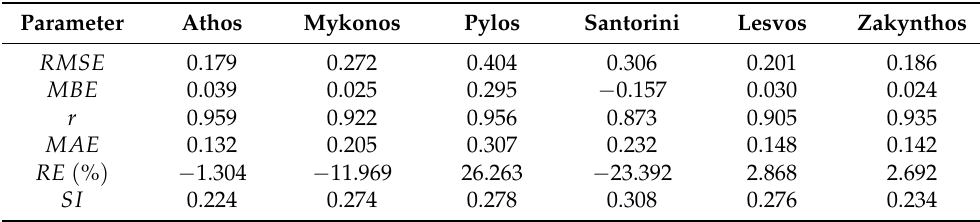
Table 2. Results of data evaluation of the significant wave height H S obtained from ERA5 and in-situ measurements. Parameter Athos Mykonos RMSE